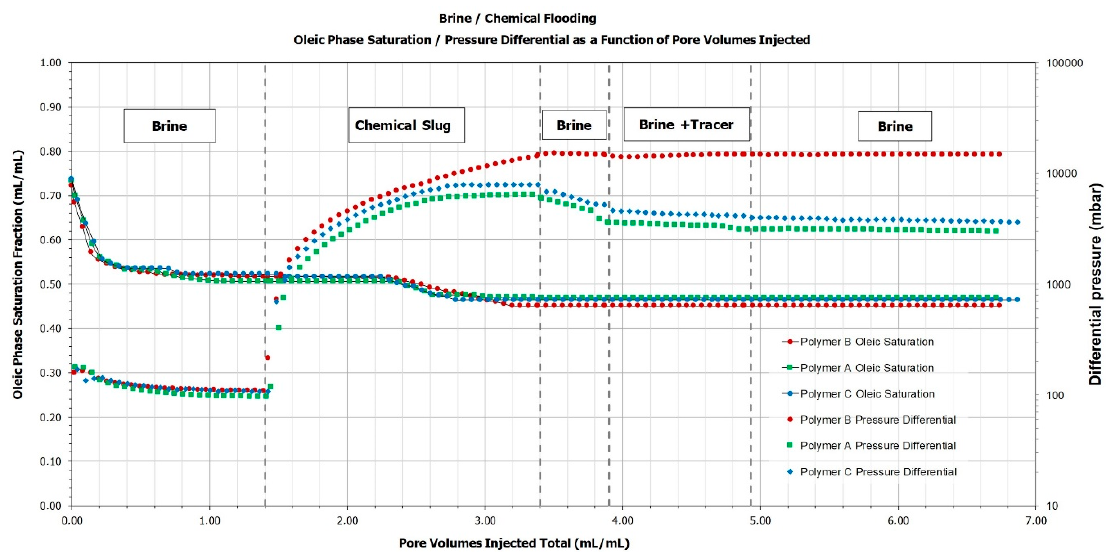
Figure 9. Oil saturation and pressure response for two phase core flood experiments. Table 5. Summary core flood results obtained for the two-phase experiments.